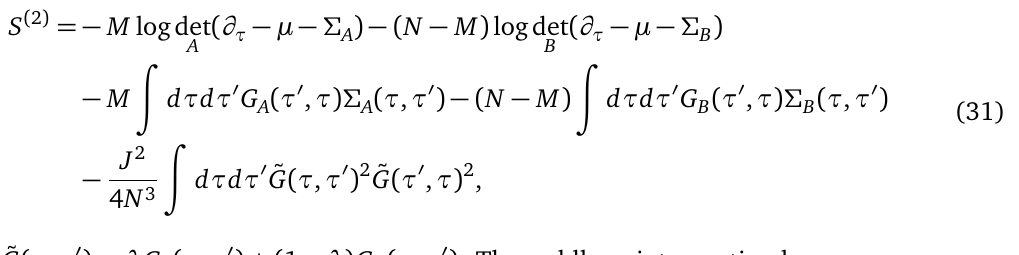
modes. With the chemical potential µ , the G − Σ action is now written